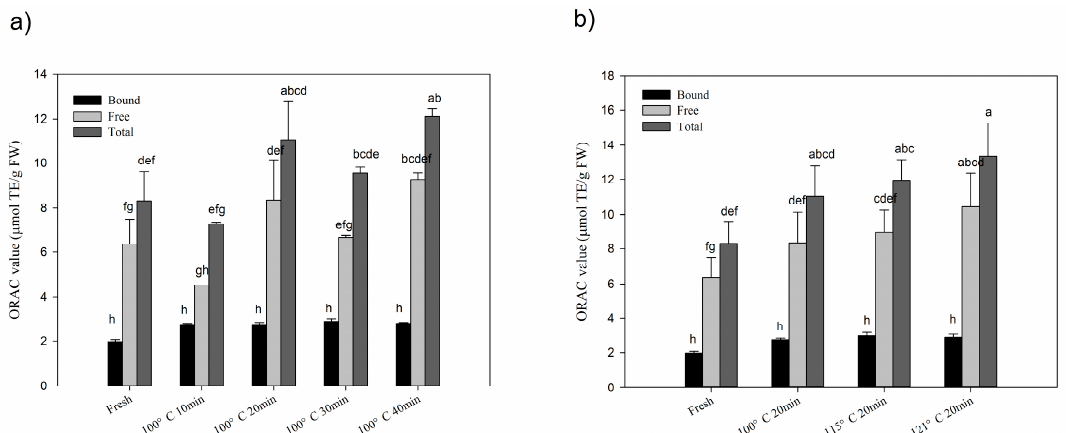
Figure 3. ( a ) Changes of antioxidant ability with time-kinetics manner at 100 ◦ C; ( b ) changes of antioxidant ability with thermal gradient manner at 20 min steaming processing. Significant differences ( p < 0.05) exist among those bars with different letters by Tuckey analysis.